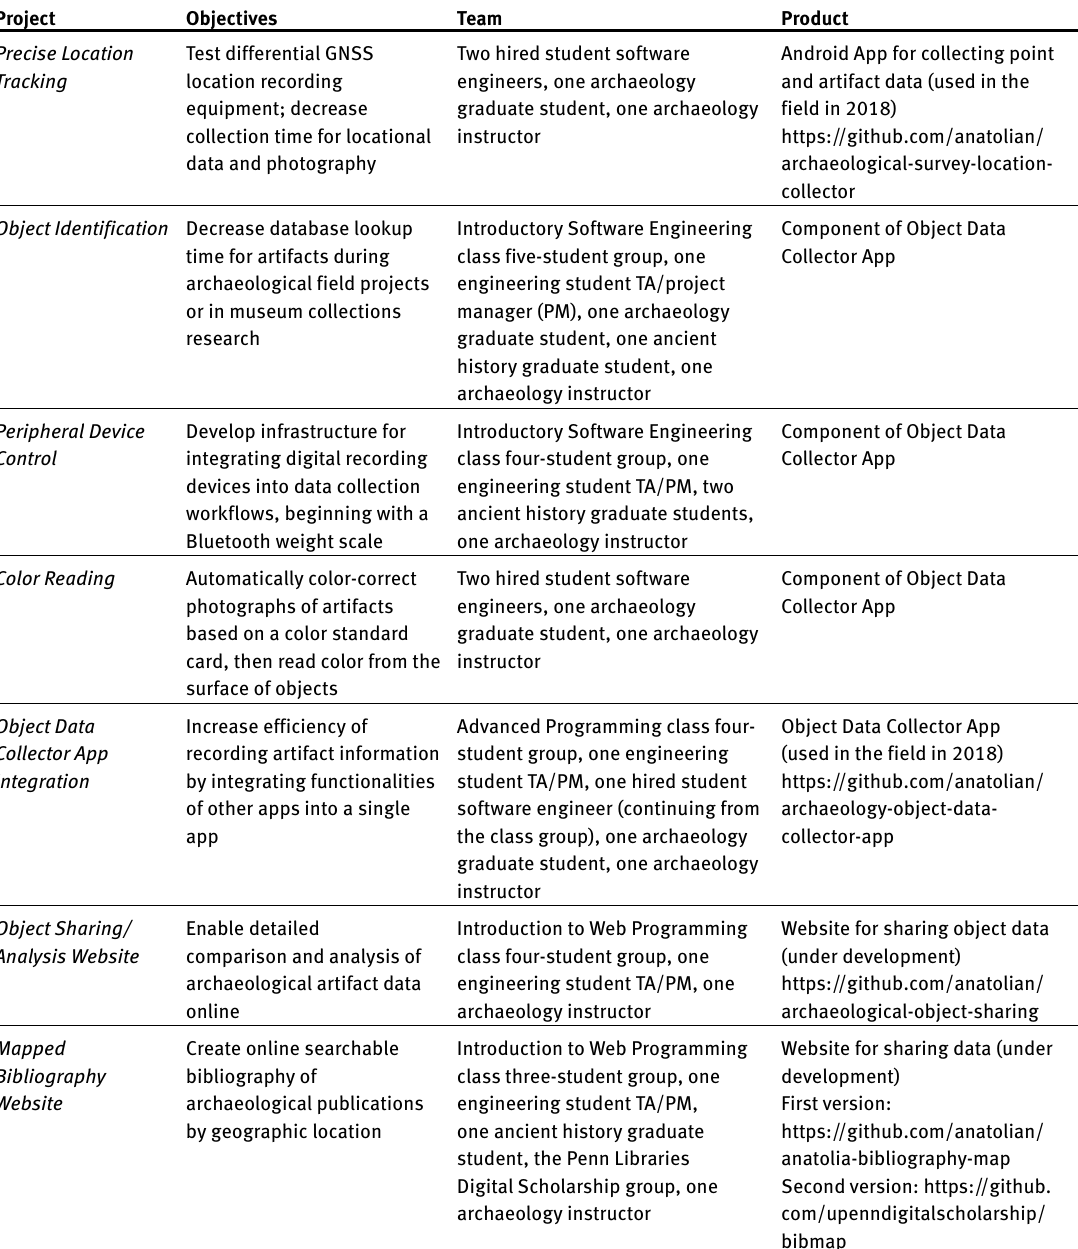
Table 1. The collaborative projects between engineers and archaeologists discussed in this